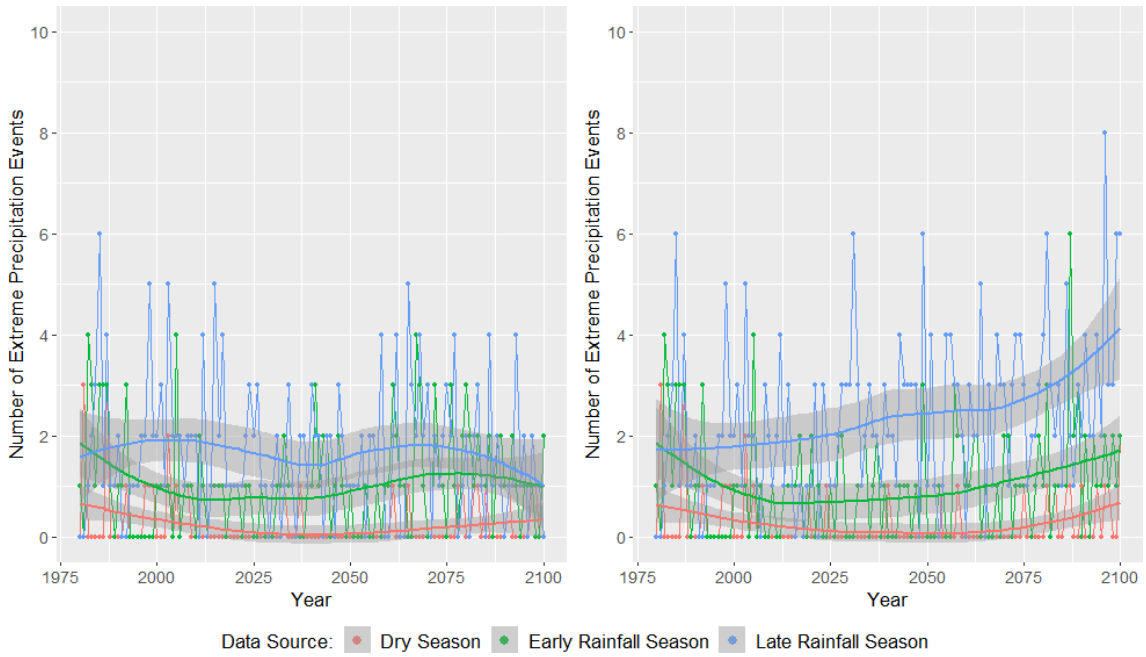
Figure B4. Total number of ER events (island daily average rainfall > 29 . 90mm) by season for the ESM2G’s RCP4.5 forcing scenario (left) and the RCP8.5 forcing scenario (right). Historical GHCN observations are also indicated on these plots (1980–2005). This figure was created using Wickham